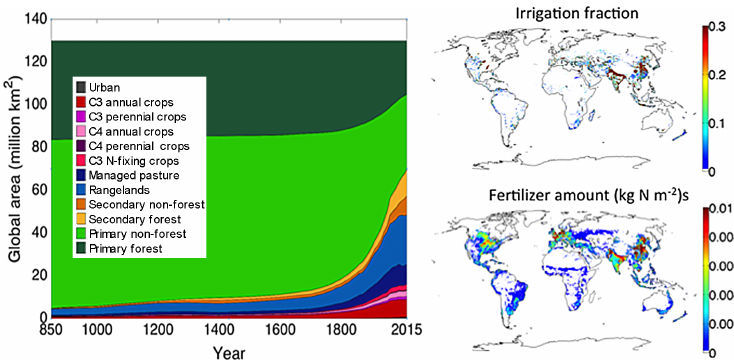
Figure 1. Time series of global land area occupied by each LUH2 land-use state from 850 to 2015 (left). Note that extensions to 2100 for all of the ScenarioMIP SSPs will also be provided. Fraction of each 0.25 ◦ grid cell that is irrigated in year 2015 (top right). Fertilizer applied in year 2015 (bottom